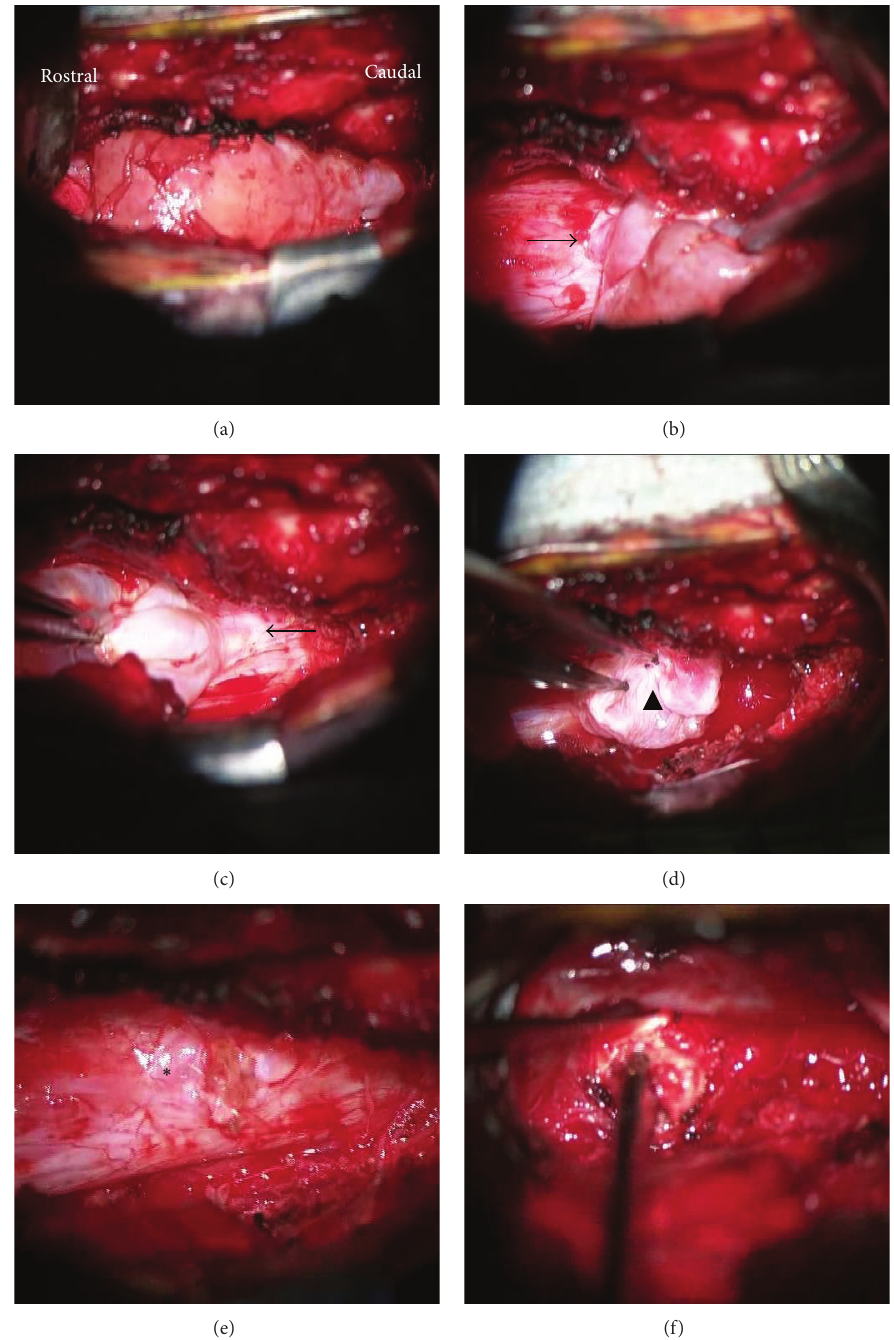
Figure 2: Intraoperative photographs. A right hemilaminectomy was performed and the epidural arachnoid cyst (EAC) was exposed (a). There is a small dural defect near the middle of the posterior wall ((b), (c) arrows). Puncturing the cyst, the site of communication (valveless) was seen ((d), arrowhead). The cyst wall was completely removed and the dural defect was closed by primary suture ((e), asterisk right). The disc herniation was excised from the right side